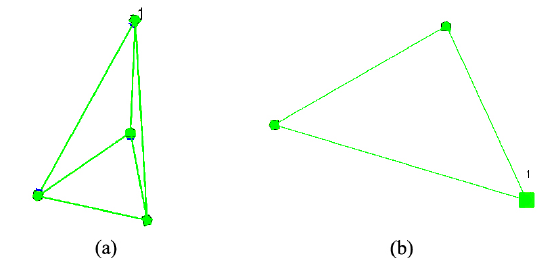
Figure 12. Simulation results for: ( a ) four robots using BDA; ( b ) three robots using